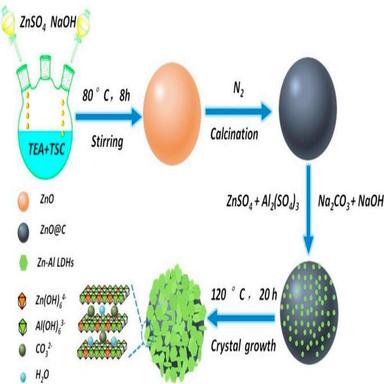
Schematic illustration of the synthesis process of the spherical ZnO@C-ZnAl LDHs composite.